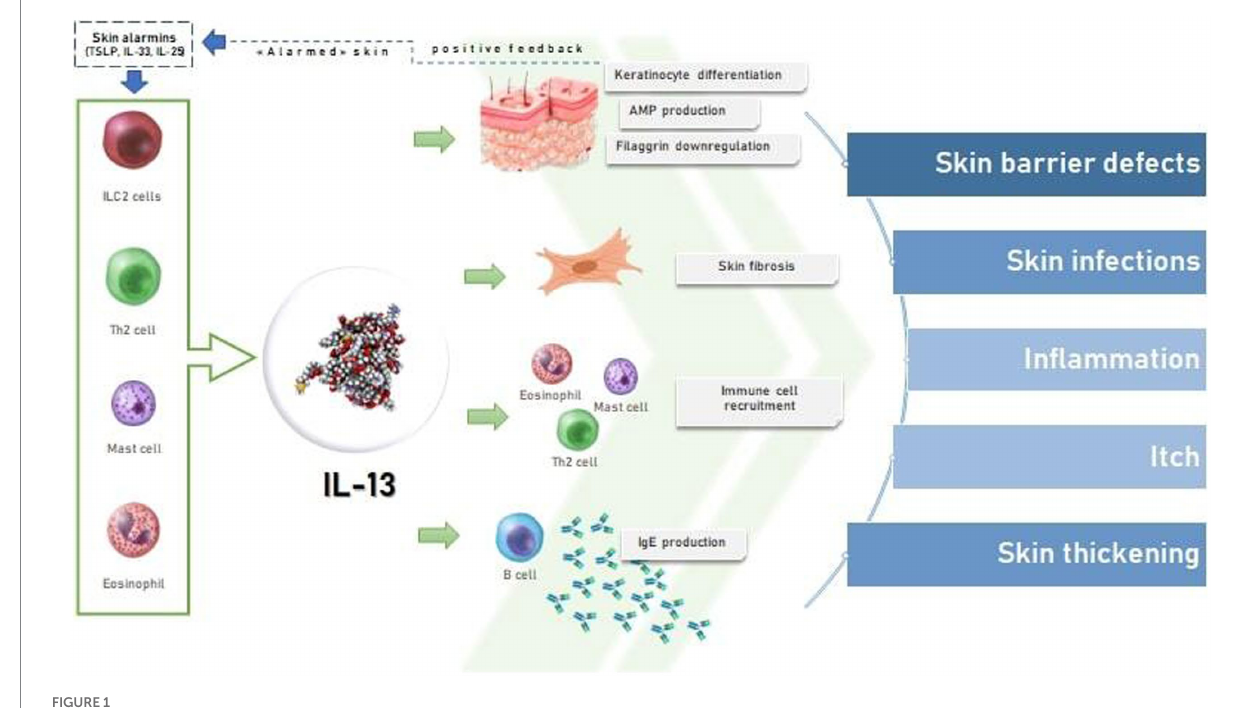
FIGURE 1 The effects of IL-13 on skin in atopic